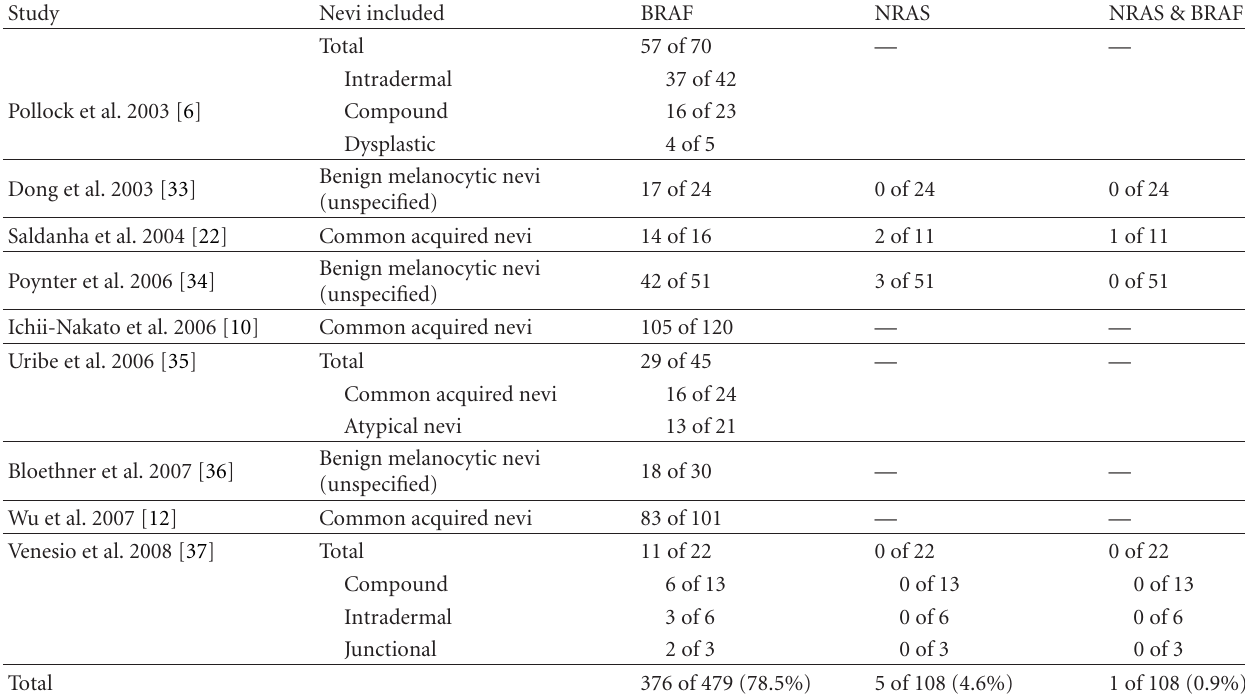
Table 3: Acquired